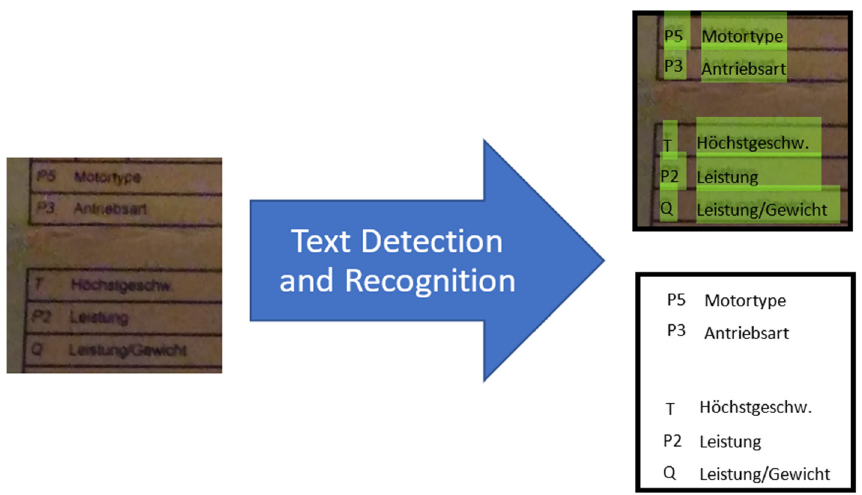
Figure 1. Optical character recognition (OCR).